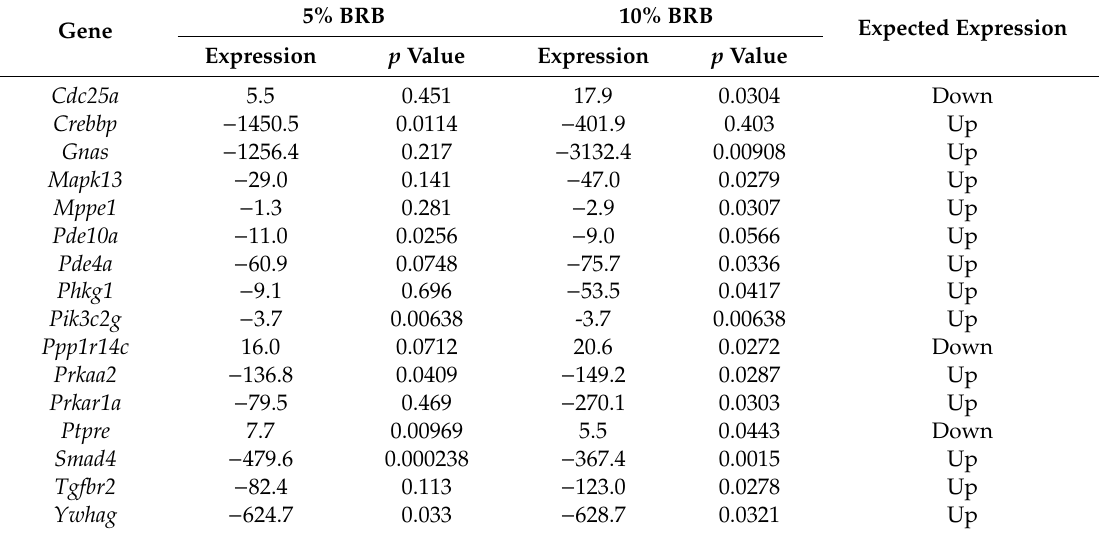
Table 3. Di ff erentially expressed PKA and AMPK pathway-associated genes in tongue samples of 4NQO exposed rats fed diets supplemented with 5% or 10% BRB as determined by RNA-Seq analysis. Data are expressed as fold change when compared to 4NQO exposed rats fed the control diet. 5% BRB 10% Gene